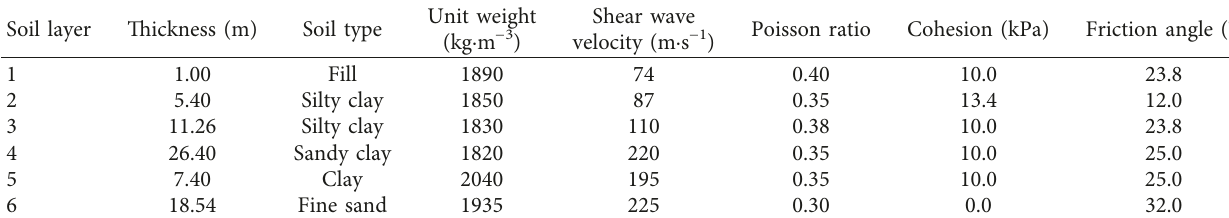
Table 5: Soil physical properties for site IV.